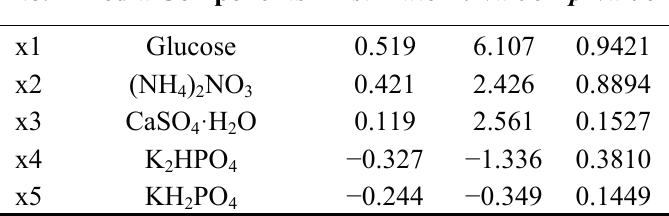
Table 3. Regression analysis indicating critical media components in the production of bioflocculant by Brachybacterium sp. and Streptomyces sp. Consortium. No. Media Components